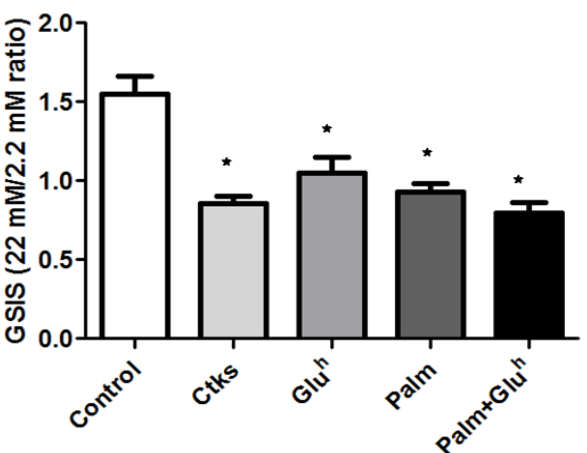
Figure 4. Cytokines, palmitate, high glucose, and high glucose+palmitate effect on 1.1E7 insulin secretion. Glucose stimulated insulin secretion (GSIS) was determined in 1.1E7 cells cultured during 48 h in the absence or presence of the indicated stimuli. Results are represented as the ratio of insulin secreted at the stimulatory glucose concentration (22 mM) to insulin secreted at the basal glucose concentration (2.2 mM). Values are represented as the mean ± SEM of four independent experiments. * p < 0.05.